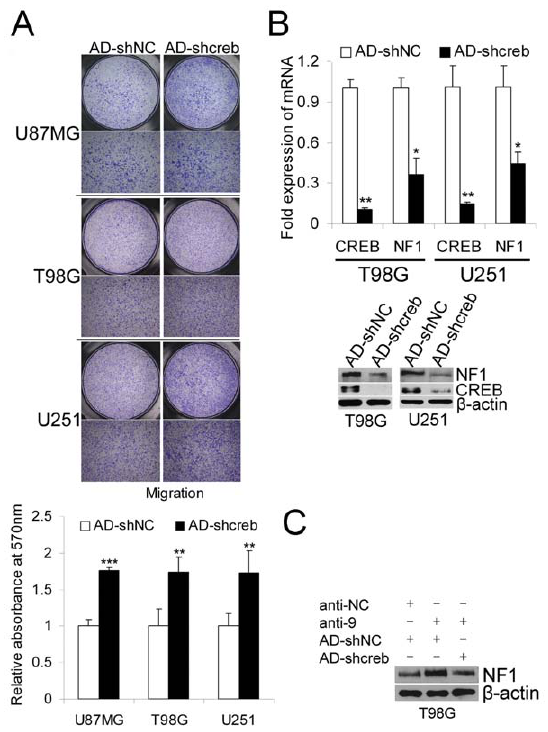
Figure 5. CREB regulates NF1 and knocking down CREB inhibits migration. (A) The migratory capacity of AD-shcreb or AD- shNC-infected U87MG, T98G and U251 cells were analyzed in a transwell migration assay (top). The bound crystal violet staining was released and quantified by measuring the OD570-630 (mean 6 SD, n=3) (bottom). (B) The mRNA and protein levels of NF1 were detected in control T98G and U251 cells or in cells with CREB knocked down by quantitative RT-PCR and western blotting, respectively. *, P , 0.05; **, P , 0.01; ***, P , 0.001, two-tailed unpaired Student’s t test. (C) T98G cells were transfected with miR-9 antagomirs or controls followed by infection of adenovirus-mediated shRNA for CREB (AD-shcreb) or AD- shNC, and the protein level of NF1 was detected by western